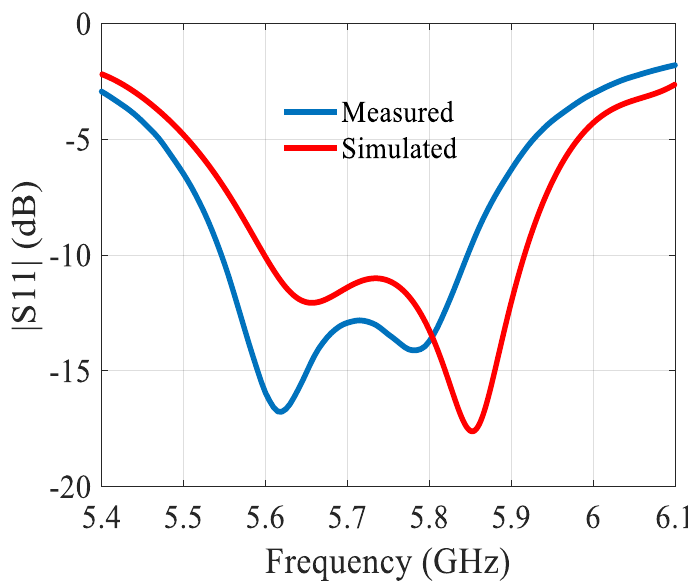
Figure 5. Reflection coefficient of the 2 × 1 building block.